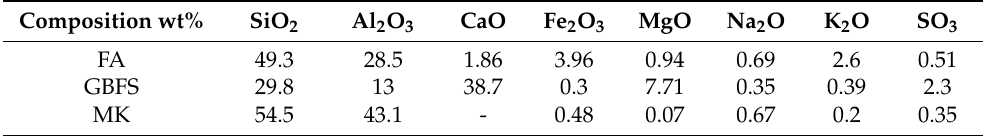
Table 1. Chemical composition of raw